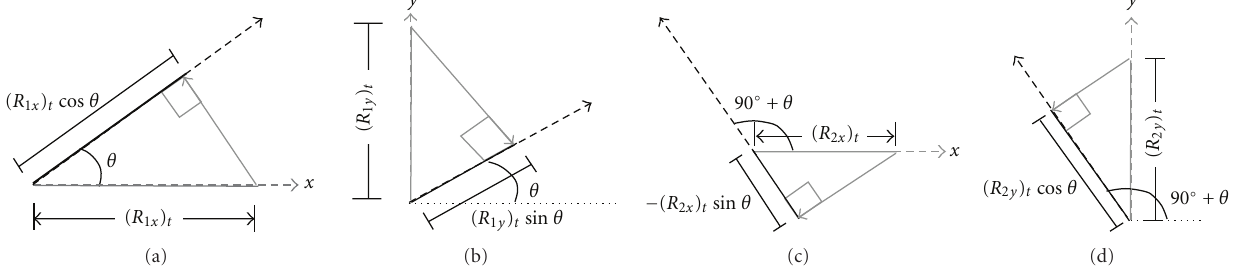
Figure 3: Schematic response of the example bridge at any time instant t under two orthogonal components of ground motion (plan view); (a) longitudinal response and its projection on θ axis under GM 1 , (b) transverse response and its projection on θ axis under GM 1 , (c) longitudinal response and its projection on (90 + θ ) axis under GM 2 , and (d) transverse response and its projection on (90 + θ ) axis under GM 2